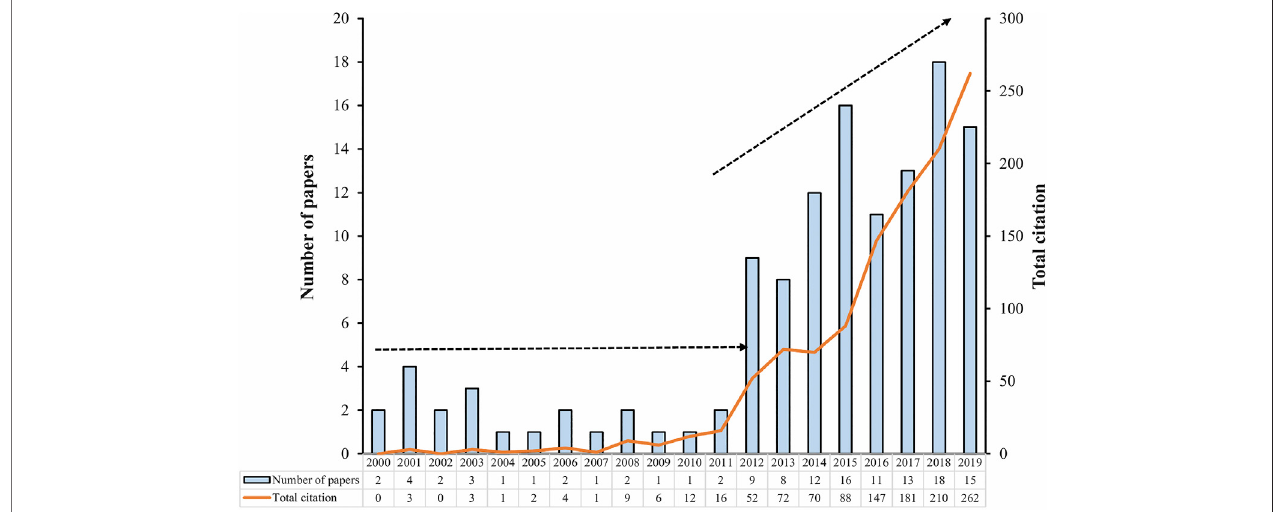
FIGURE 1 | A pictorial depiction of the steadily growing interest in the research on EBN from 2000 to 2019.